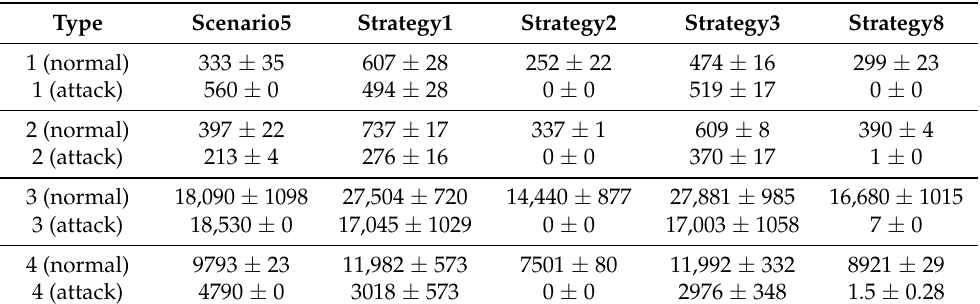
Table 7. Confidential intervals of the flow table space usage for the traffic traces, 1—UNIV1, 2—SimpleWeb, 3—MAWI and